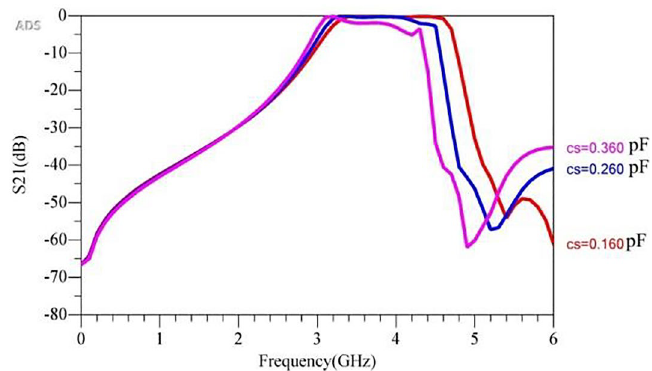
Figure 11. Frequency simulation response of the filter for various values of Cs.